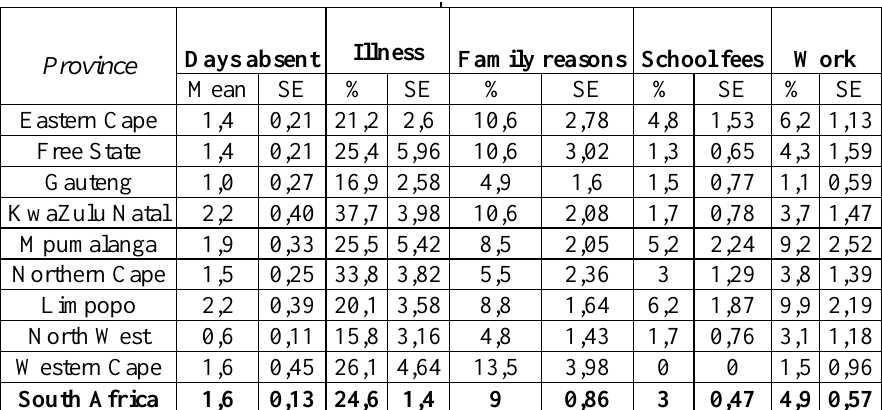
Table 4: Absenteeism and